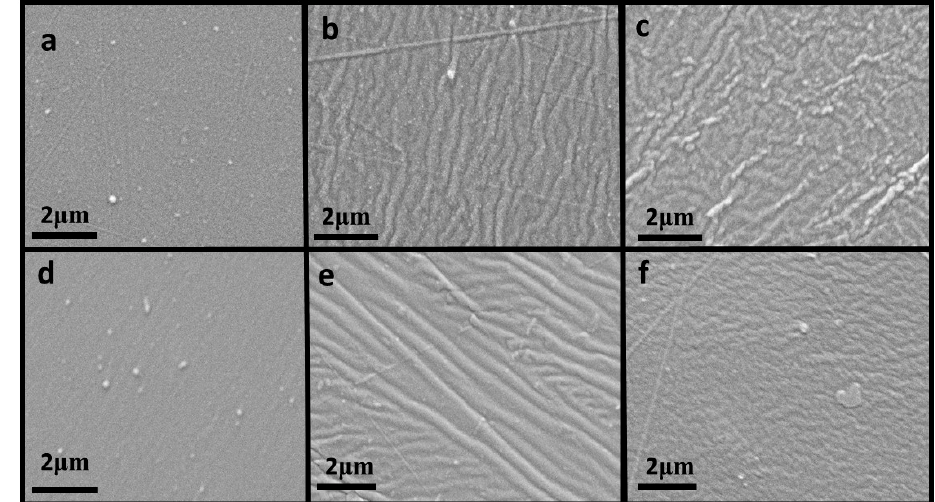
Figure 2. Photomicrograph of test samples at magnification of 5 K. ( a ) SiTTOBAu at Day 1 ( b ) SiTTOBAu at 6 months ( c ) SiTTOBAu at 12 months ( d ) SiMOBAu at Day 1 ( e ) SiMOBAu at 6 months and ( f ) SiMOBAu at 12 months.